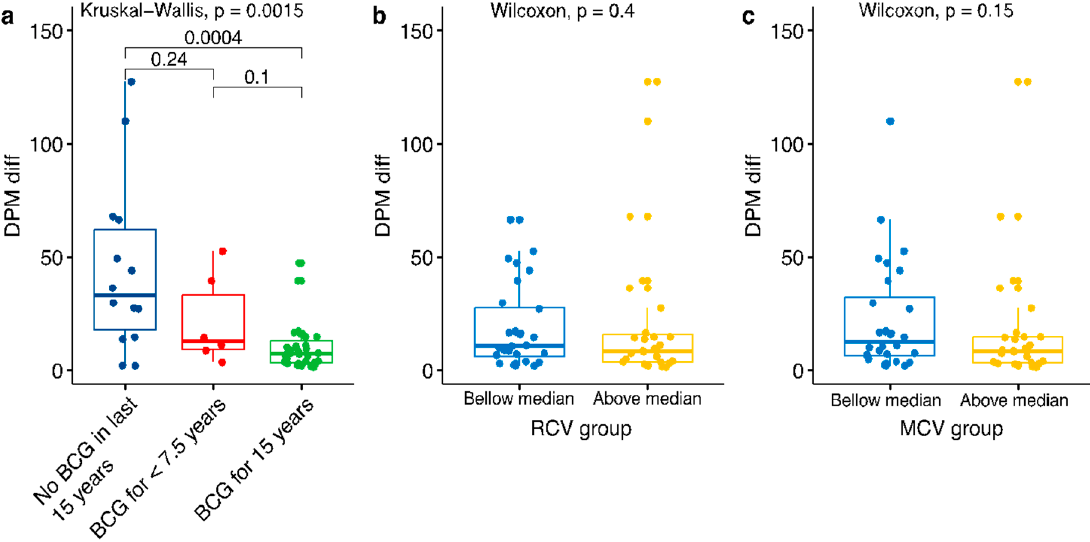
Figure 6. Immunization coverage for the last 15 years. ( a ) The DPM diff. (difference in DPM from the value at alignment key date) in countries that have (green), partially have (red), or have not (blue) rolled immunization BCG programs over the past 15 years. The statistical significance values are shown for each pair. ( b ) The statistics of RCV (rubella) and ( c ) MCV (measles) vaccines and COVID-19 DPM diff. according to the vaccination coverage. The partition of the countries is according to those above (yellow) and below (blue) median % coverage for each of these tested vaccines. Data covering the past 15 years (2004–2018) was extracted from WHO reports. The statistical significance values are listed.